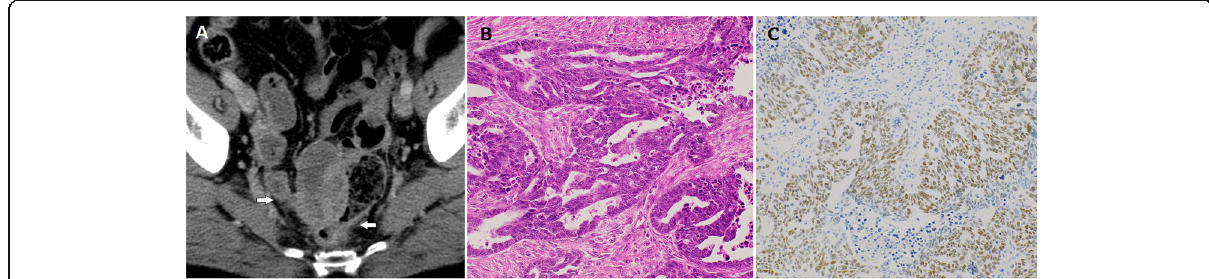
Fig. 1 Contrast-enhanced computed tomography showing a pelvic peritoneal mass with irregular enhancement in the neighboring ileum and rectum. Ovaries and regional lymph nodes were not involved ( a ). Histological examination revealed irregular clusters of malignant cells with slit- like glandular spaces (magnification × 200) ( b ). Immunohistochemically, the tumor was positive for Wilms tumor-1 (× 200) ( c )